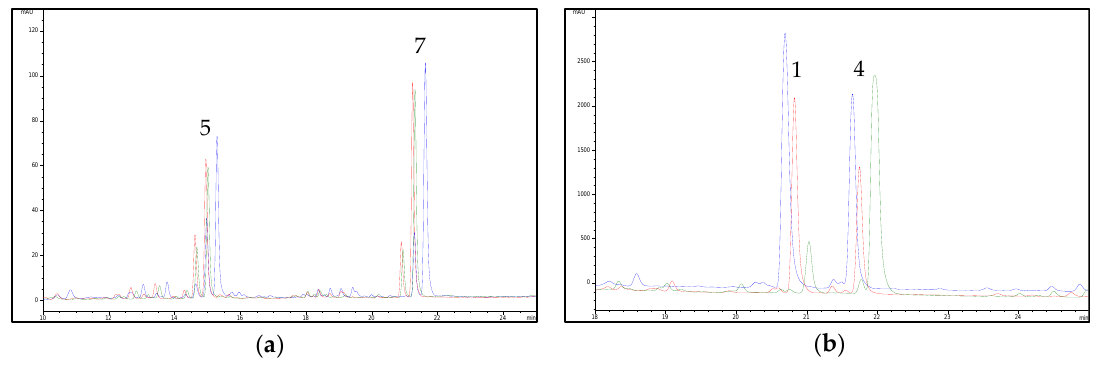
Figure 6. ( a ) Effect of different thermal treatments on flavonoid extraction from hemp (sample C6). Chromatograms obtained at 342 nm without thermal treatment (blue line), with thermal treatment at 80 °C for 2 h (red line), with thermal treatment at 120 °C for 1 h (green line). For peak numbering, see Table 1. ( b ) Effect of different thermal treatments on cannabinoid removal from hemp (sample C6). Chromatograms obtained at 210 nm without thermal treatment (blue line), with thermal treatment at 80 °C for 2 h (red line), with thermal treatment at 120 °C for 1 h (green line). For peak numbering, see Table 1.